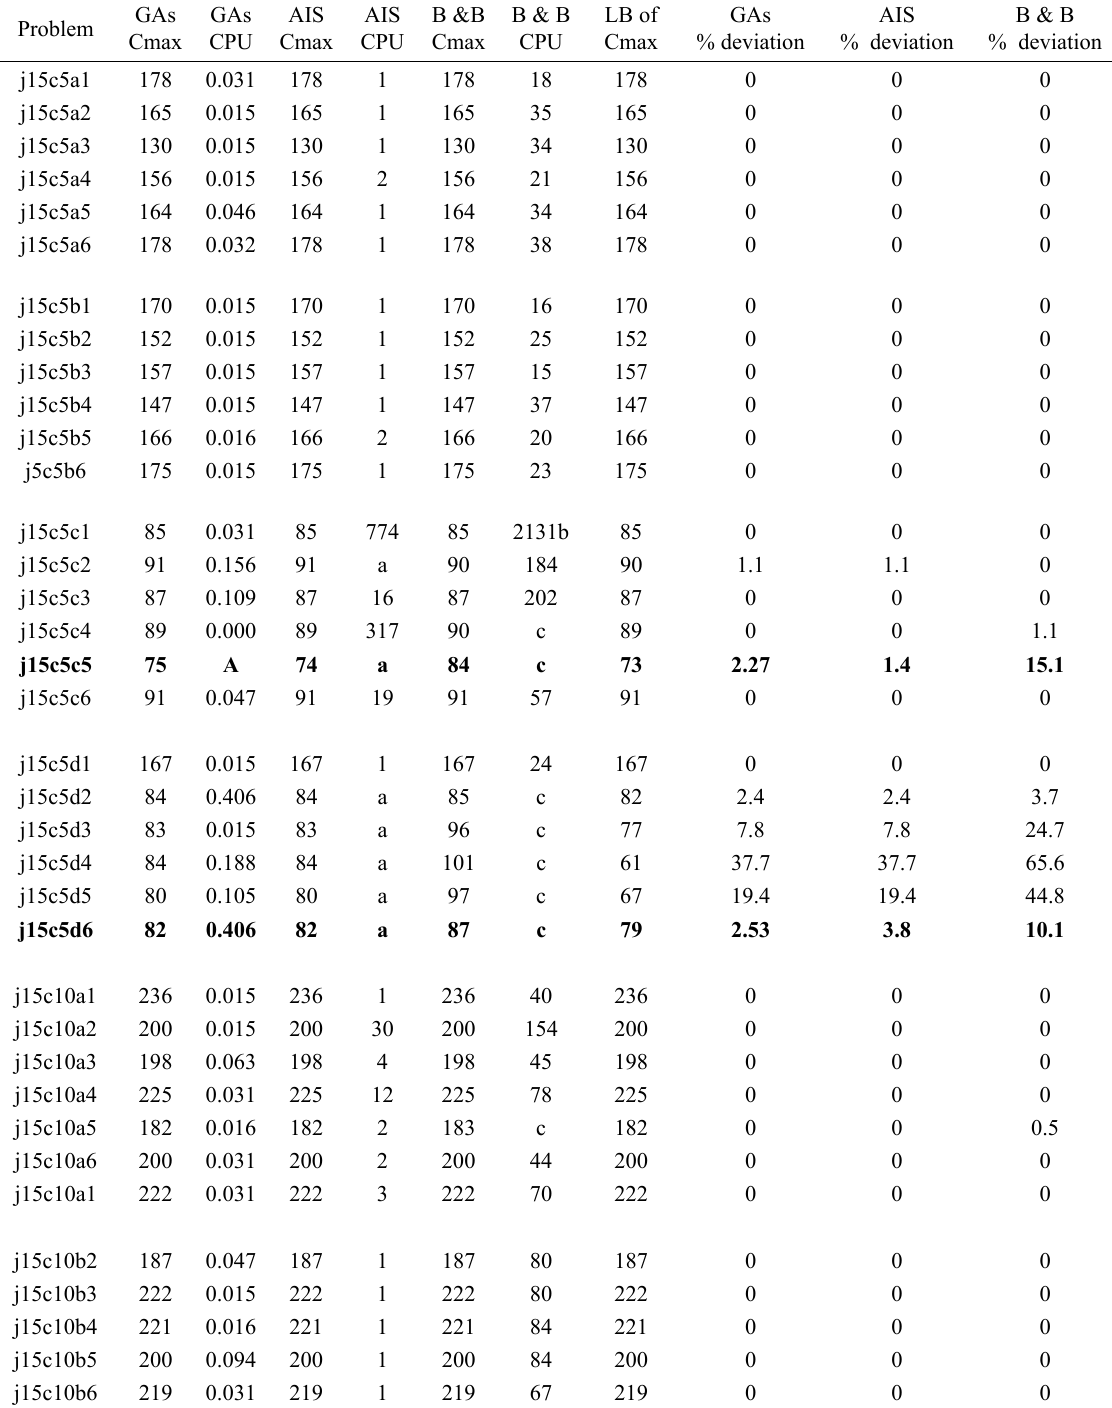
Table 4: Solutions of Test Problems